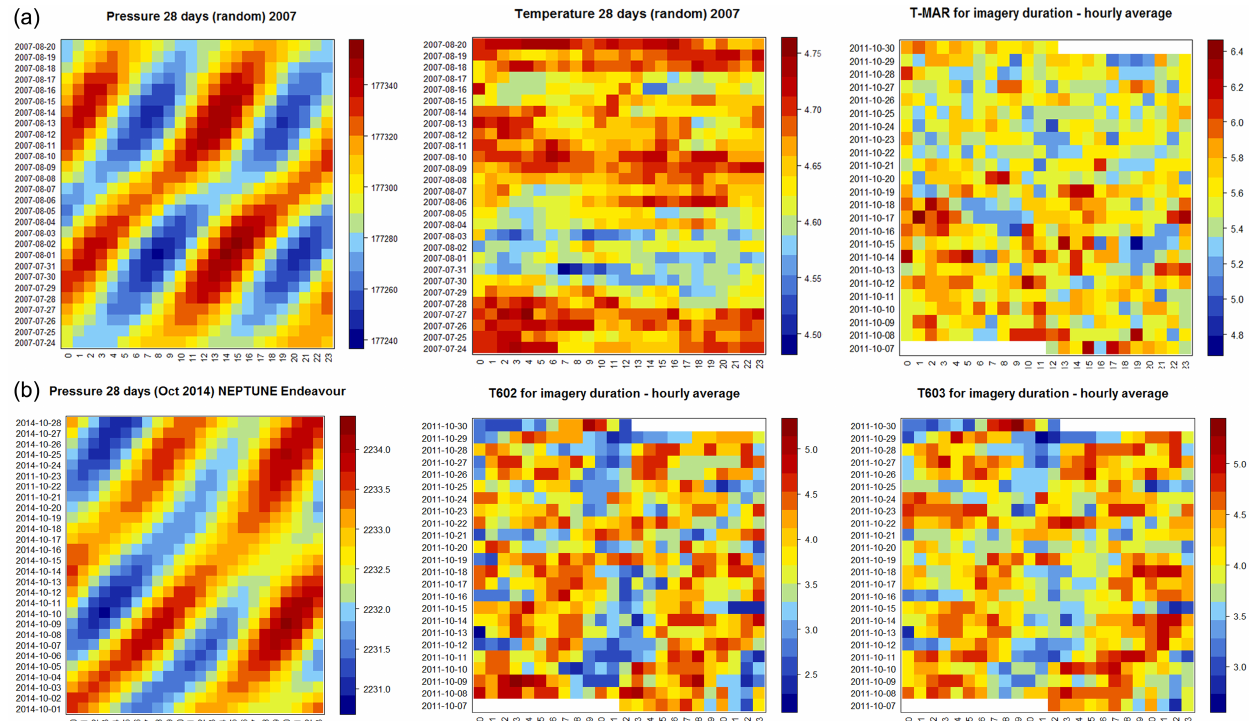
Figure A3. Comparison of cyclicity in pressure data and temperature for (a) MAR and (b) NEP. Red shows higher values while blue indicates the lowest values. Pressure data for MAR originate from 2007 to 2008 and were recorded at SeaMoN West of the EMSO-Azores observatory and represents a random 28 day (lunar) period (data courtesy of Valerie Ballu). Pressure data for NEP were downloaded from ONC Portal from the BPR (NRCan Bottom Pressure Recorder deployed at MEF/Endeavour) (Ocean Networks Canada Data Archive, http: //www.oceannetworks.ca; total pressure data from 1 to 29 October 2014, University of Victoria, Canada, downloaded on 16 June 2015). A random selection of 28 days in October 2014 is presented here (no earlier data were